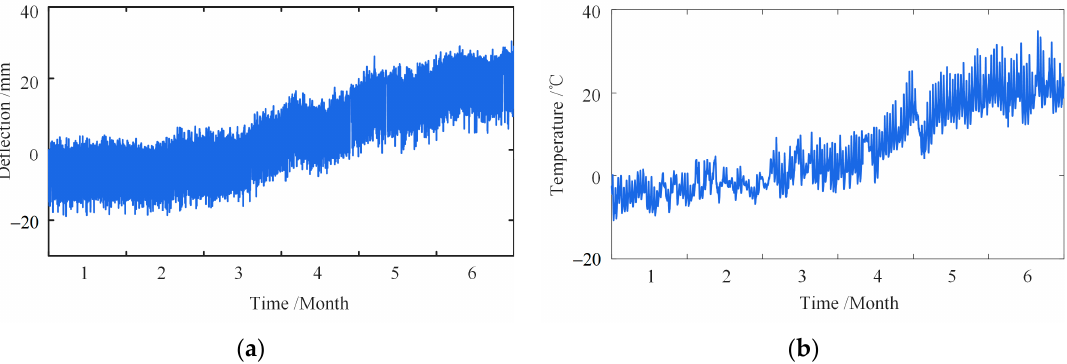
Figure 17. In situ measured signal of the bridge. ( a ) In situ measured deflection; ( b ) effective temperature.